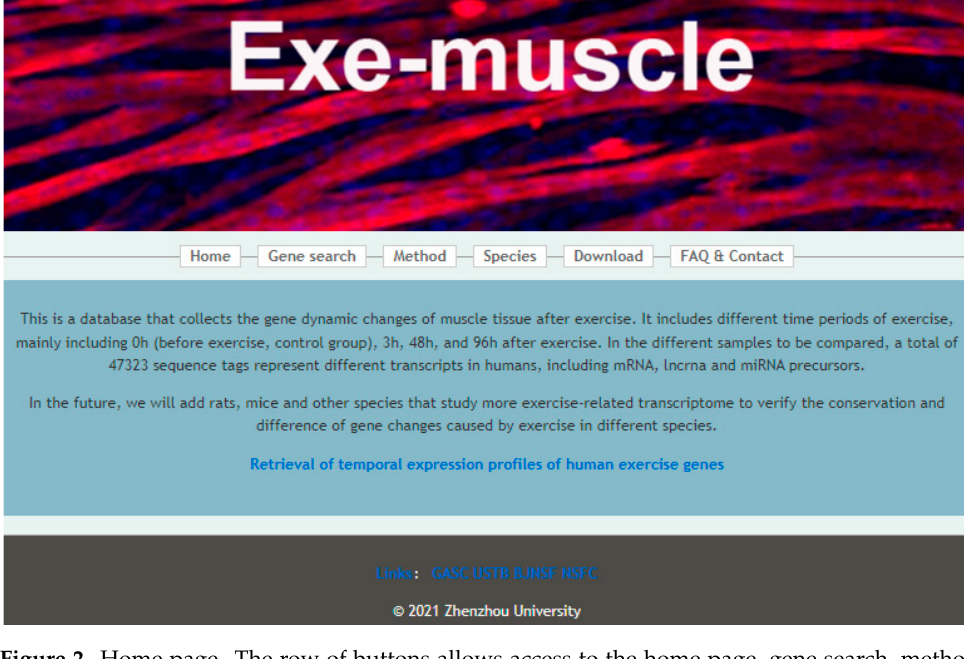
Figure 3. Gene search page of Exe-muscle. This page includes blanks for entering information about the desired gene, such as the Unigene ID, tag sequence, count, Chr ID, Entrez ID, and ontology. α -Actinin-3 (ACTN3), also known as the exercise gene, encodes a myofibril protein, fixes different actins and assists in muscle contraction. Previous studies showed that ACTN3 is an essential gene during exercise. The gene’s function relates to the explosive power of skeletal muscle. The proportion of the ACTN3 gene in endurance sports athletes is about 50%, which is not significantly different from that of the general population. By testing, the proportion of normal ACTN3 carried by high-level athletes participating in explosive events (e.g., sprint and long jump) in the Olympic Games was 95%. In compar- ison, 100% of female athletes in some individual events carried the gene [31,32]. We use ACTN3 as an example to demonstrate the use method and function of the Exe-muscle database. One can quickly enter the gene search page by understanding Exe- muscle’s overall framework. Directly enter “ACTN3” in the keyword search and click search. ACTN3 appears at the bottom of the page. Its gene number (NM_001104.1) ap- pears with the tag sequence used in the gene chip and the corresponding gene expression (number of reads) at 0 h before exercise and 3, 48, and 96 h after exercise (1811, 2022, 1142, and 1336, respectively). The gene description follows this information as “ Homo sapiens